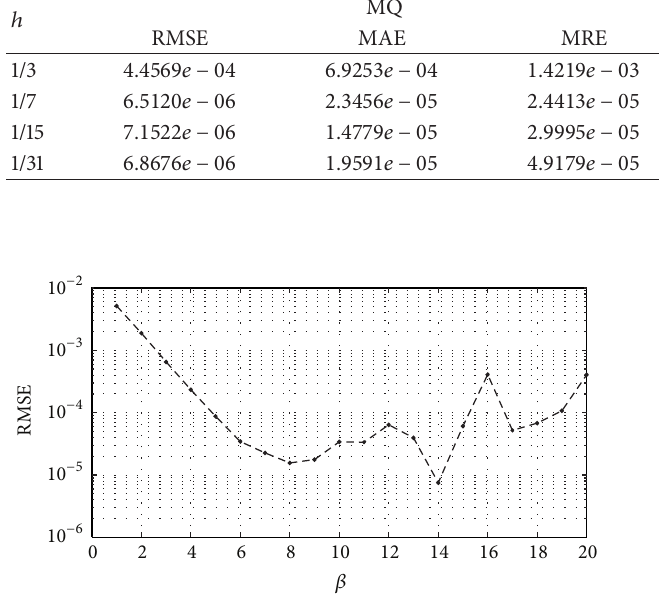
Figure 2: The RMSE curve versus the shape parameter 𝛽 with ℎ = 1/10 .